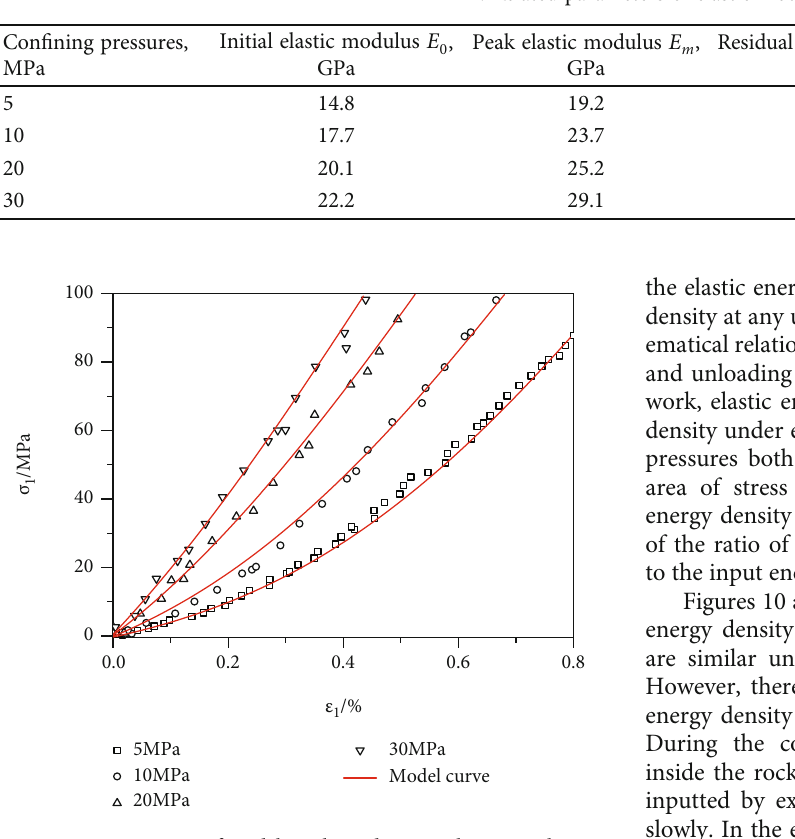
Figure 8: Comparison of model results and test results at initial stage of axial stress-strain curves under di ff erent con fi ning